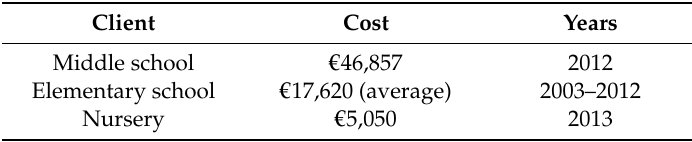
Table 4. Energy costs for buildings involved.